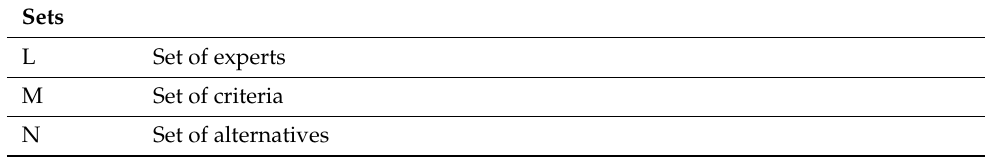
Table 3. Sets, parameters, and variables for